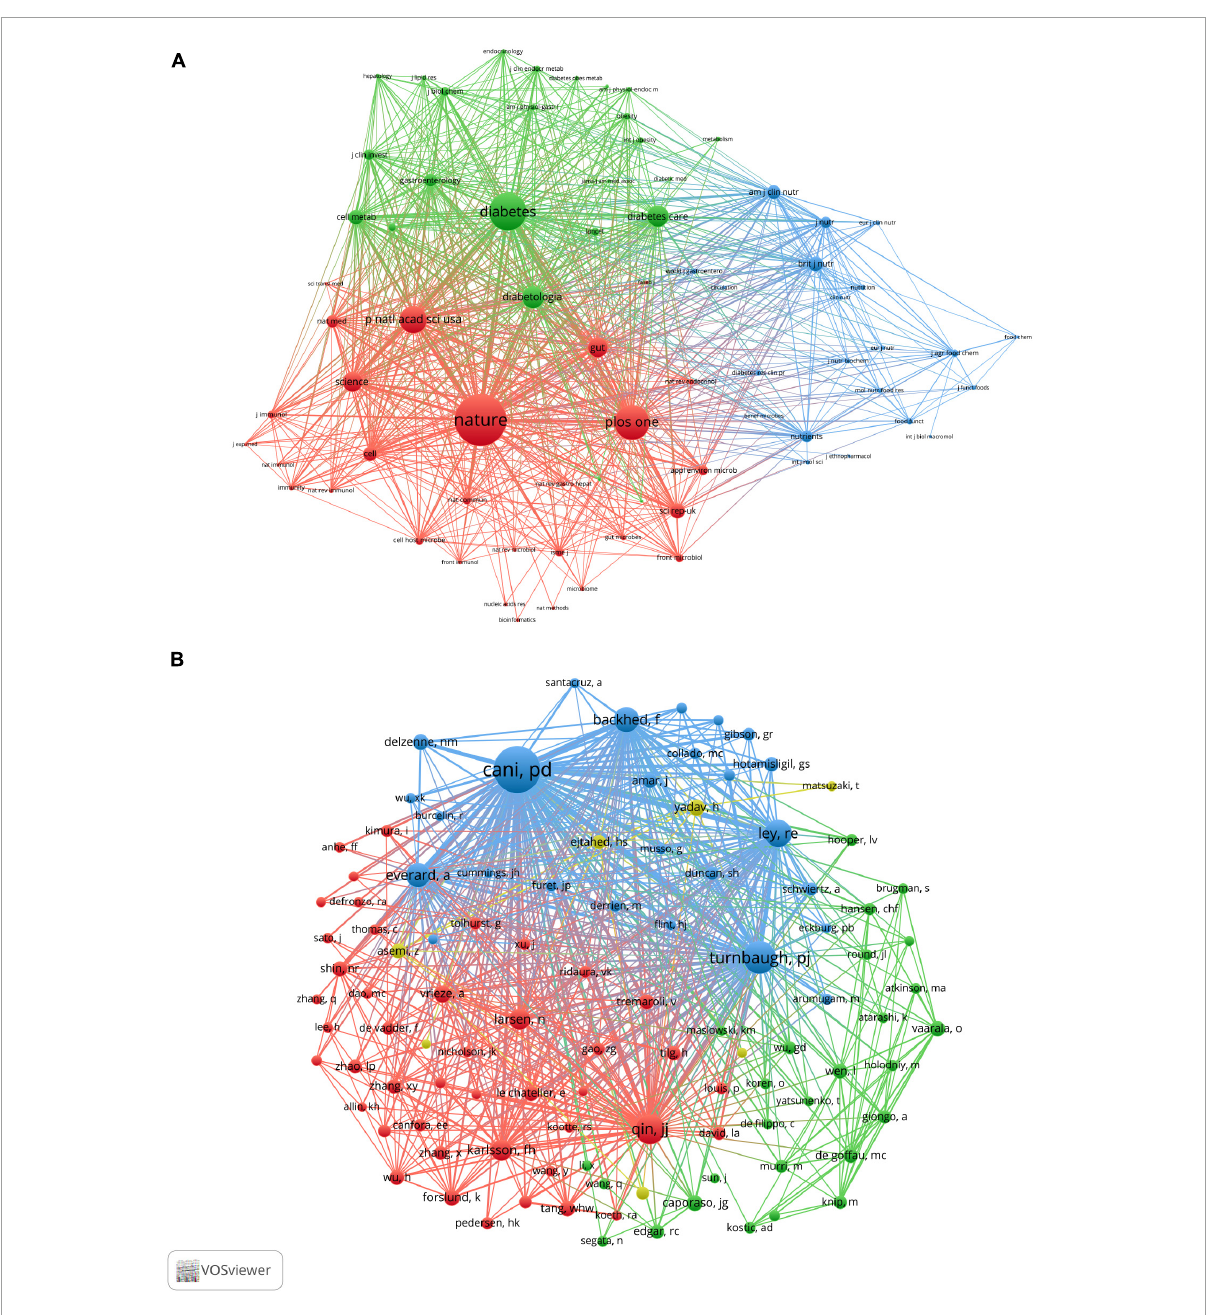
FIGURE4 VOSviewer network visualization map of co-cited journals and authors of the publications related to the “gut microbiota and diabetes” area. (A) Visualization map of co-cited journals. (B) Visualization map of co-cited authors.